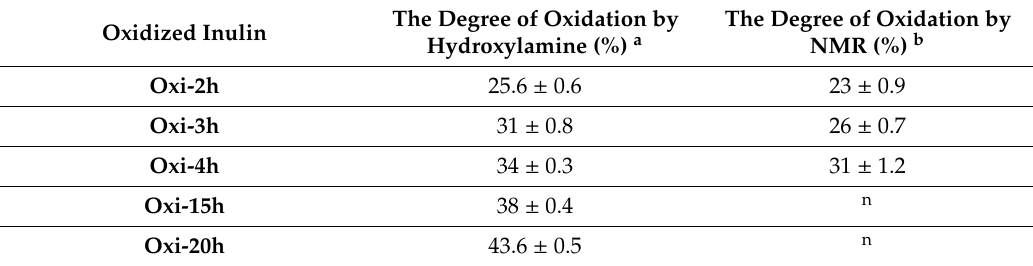
Table 1. The aldehyde content determination using 1 H NMR spectroscopy and hydroxylamine titration. The Degree of Oxidation by The Degree of Oxidation Oxidized Inulin Hydroxylamine (%) a